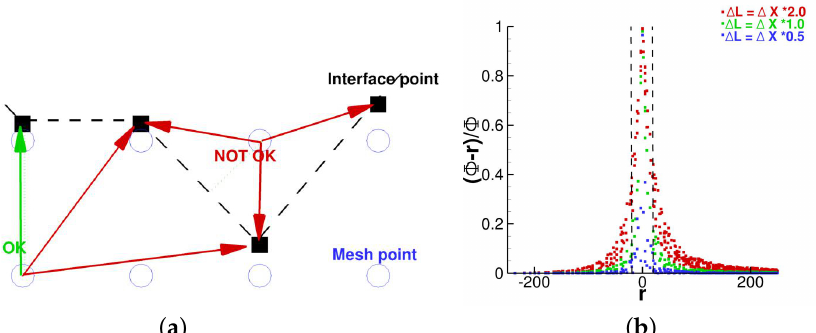
Figure A2. ( a ) Errors introduced by the discrete nature of the interface during the LSF computation; ( b ) Dependence of the LSF-relative uncertainty ( φ theo = r ) with the ∆ L / ∆ X resolution ratio (cylinder